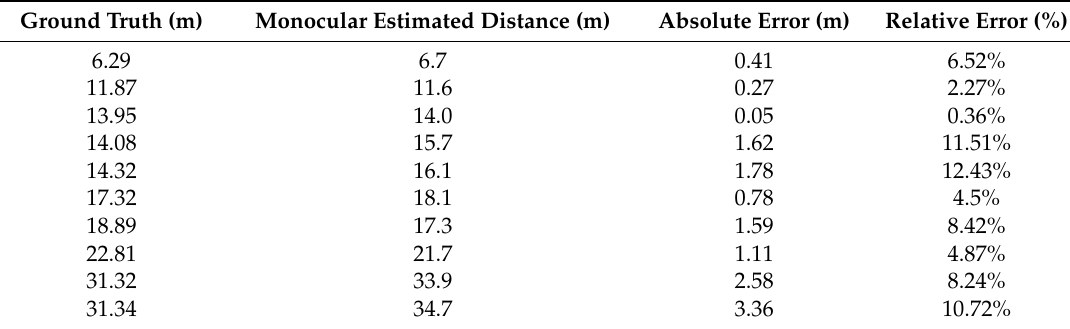
Table 5. Distance measurement accuracy—comparison with laser data. Ground Truth (m) Monocular Estimated Distance (m) Absolute Error